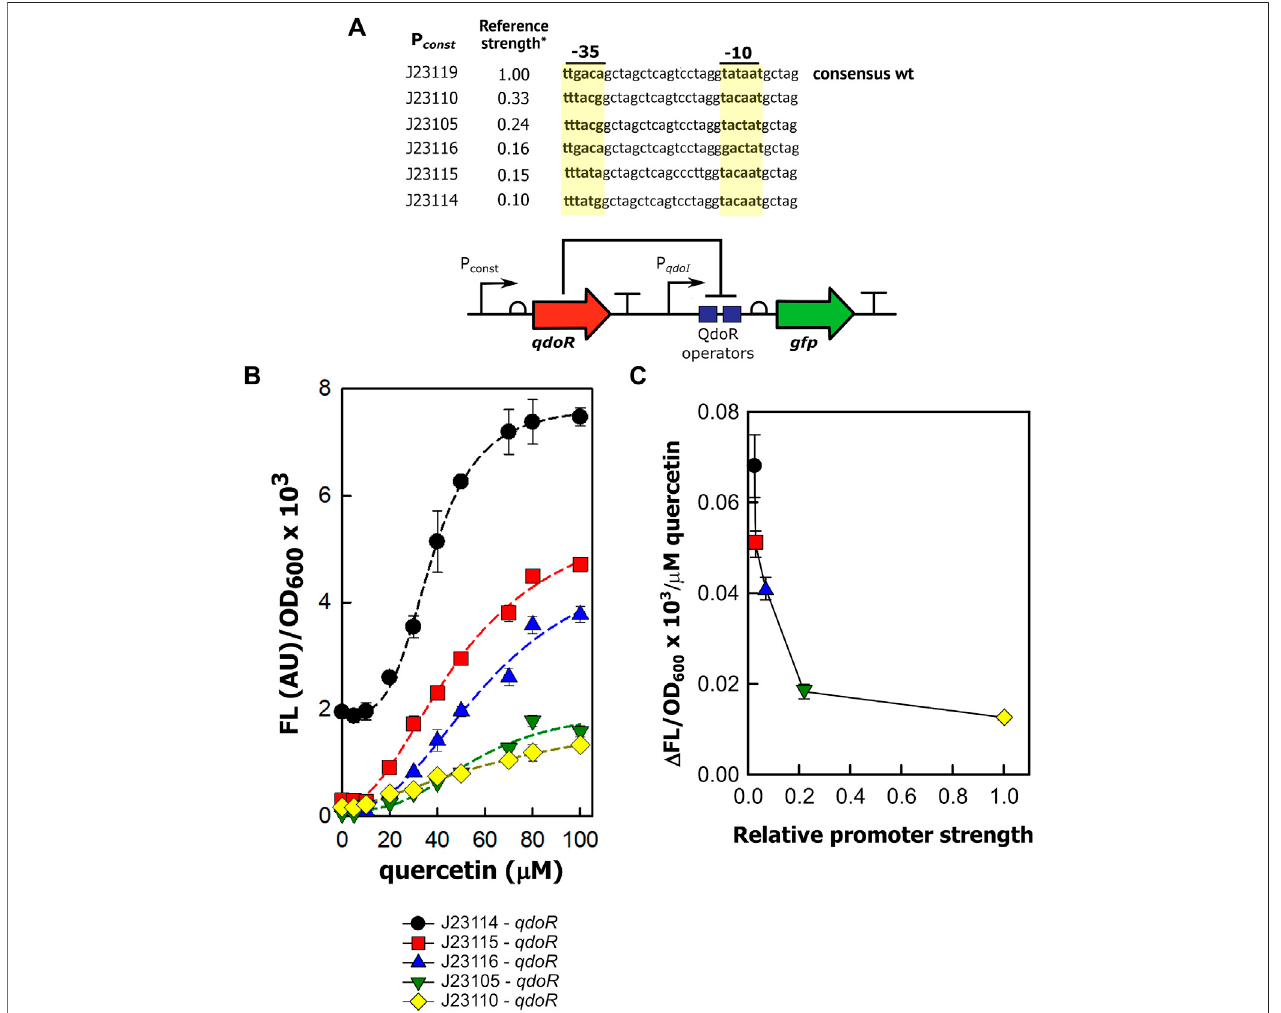
FIGURE2| TheexpressionofQdoRcanbeadjustedtogivestaggeredoutputs. (A) In fi vedifferentconstructions,constitutivepromoters(P const )withdifferenttranscriptional strengths were inserted upstream of qdoR . The promoter sequences are shown, with the − 35 and − 10 recognition sites in bold and highlighted in yellow. The top sequence is